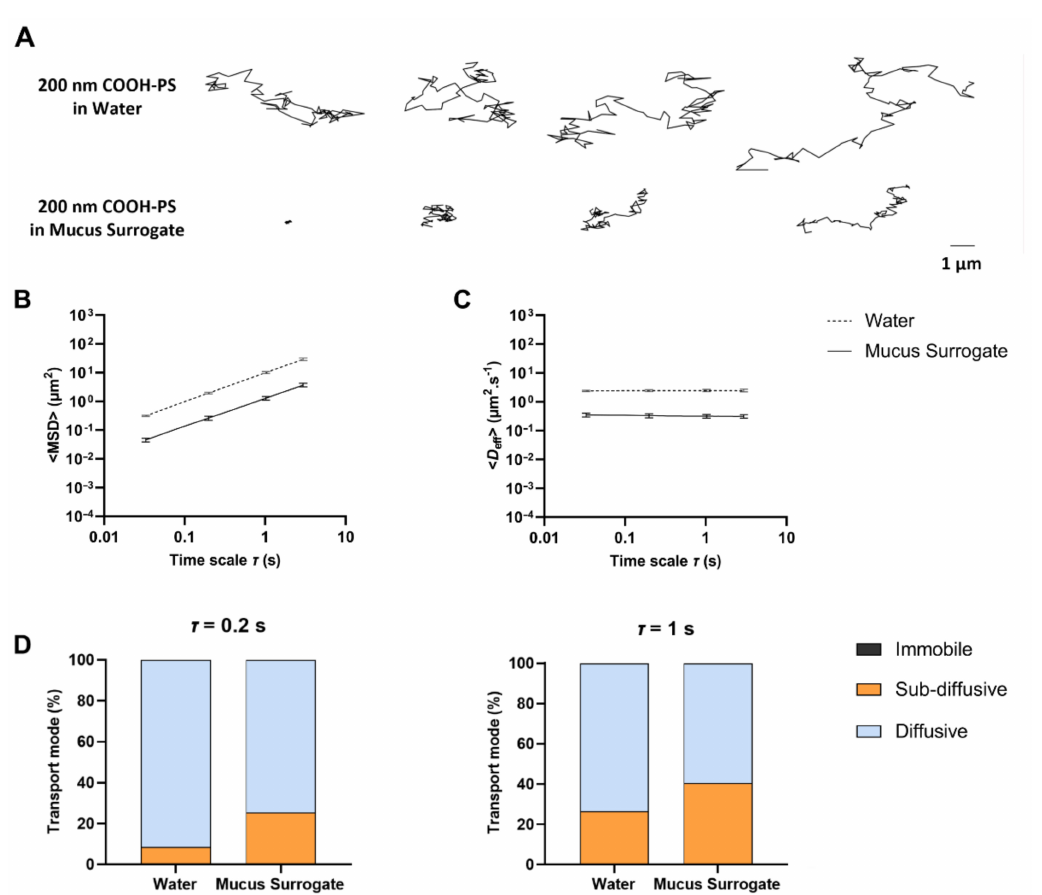
Figure 5. Transport behavior of 200 nm COOH-PS NPs in water or mucus surrogate containing 3% mucin. ( A ) Representative trajectories for a total duration of 3 s. Values for ( B ) <MSD> and ( C ) < D eff > of 200 nm COOH-PS NPs in water or mucus surrogate containing 3% mucin as a function of time scale. Data presented as mean ± SD ( n = 3). ( D ) Distribution of 200 nm COOH-PS NPs in water and mucus surrogate (3% mucin) according to transport mode for τ = 0.2 s and τ = 1 s (data presented as mean values; n =